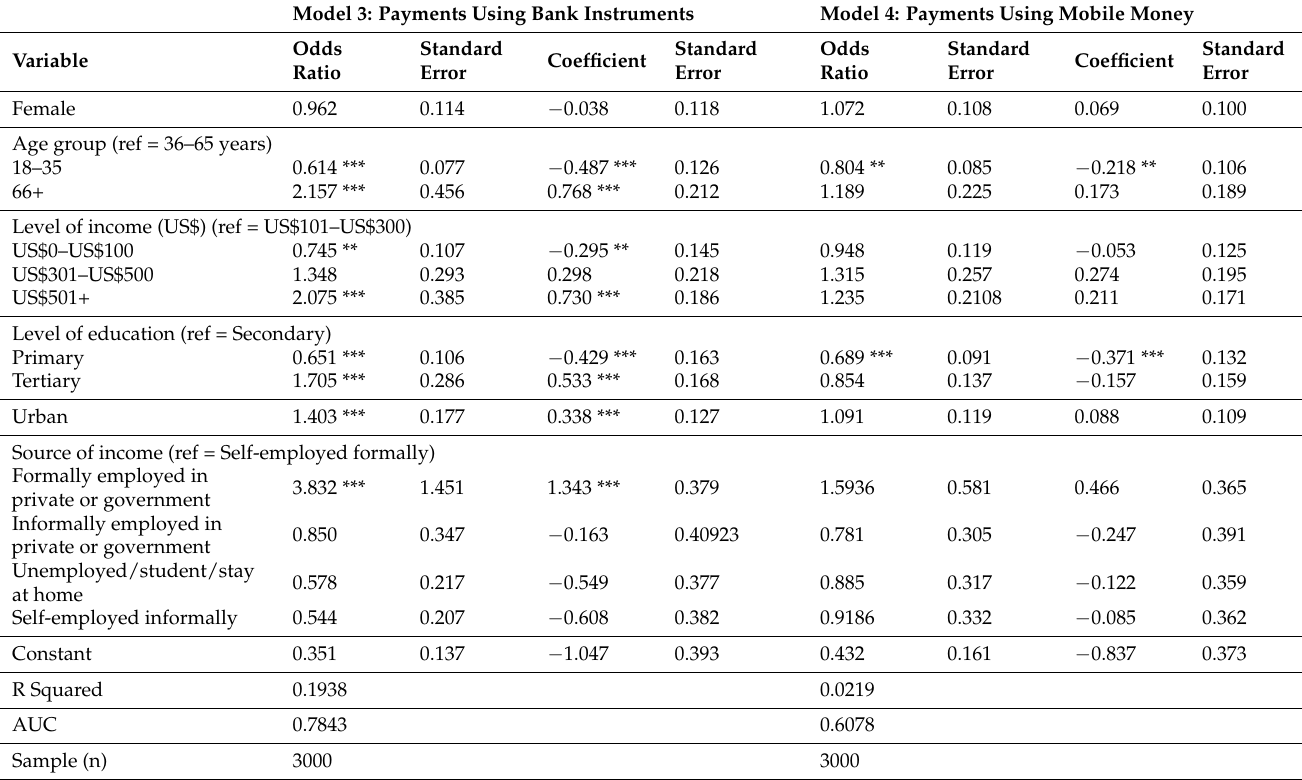
Table 4. Factors associated with making digital payments (bank or mobile money). Model 3: Payments Using Bank Instruments Model 4: Payments Using Mobile